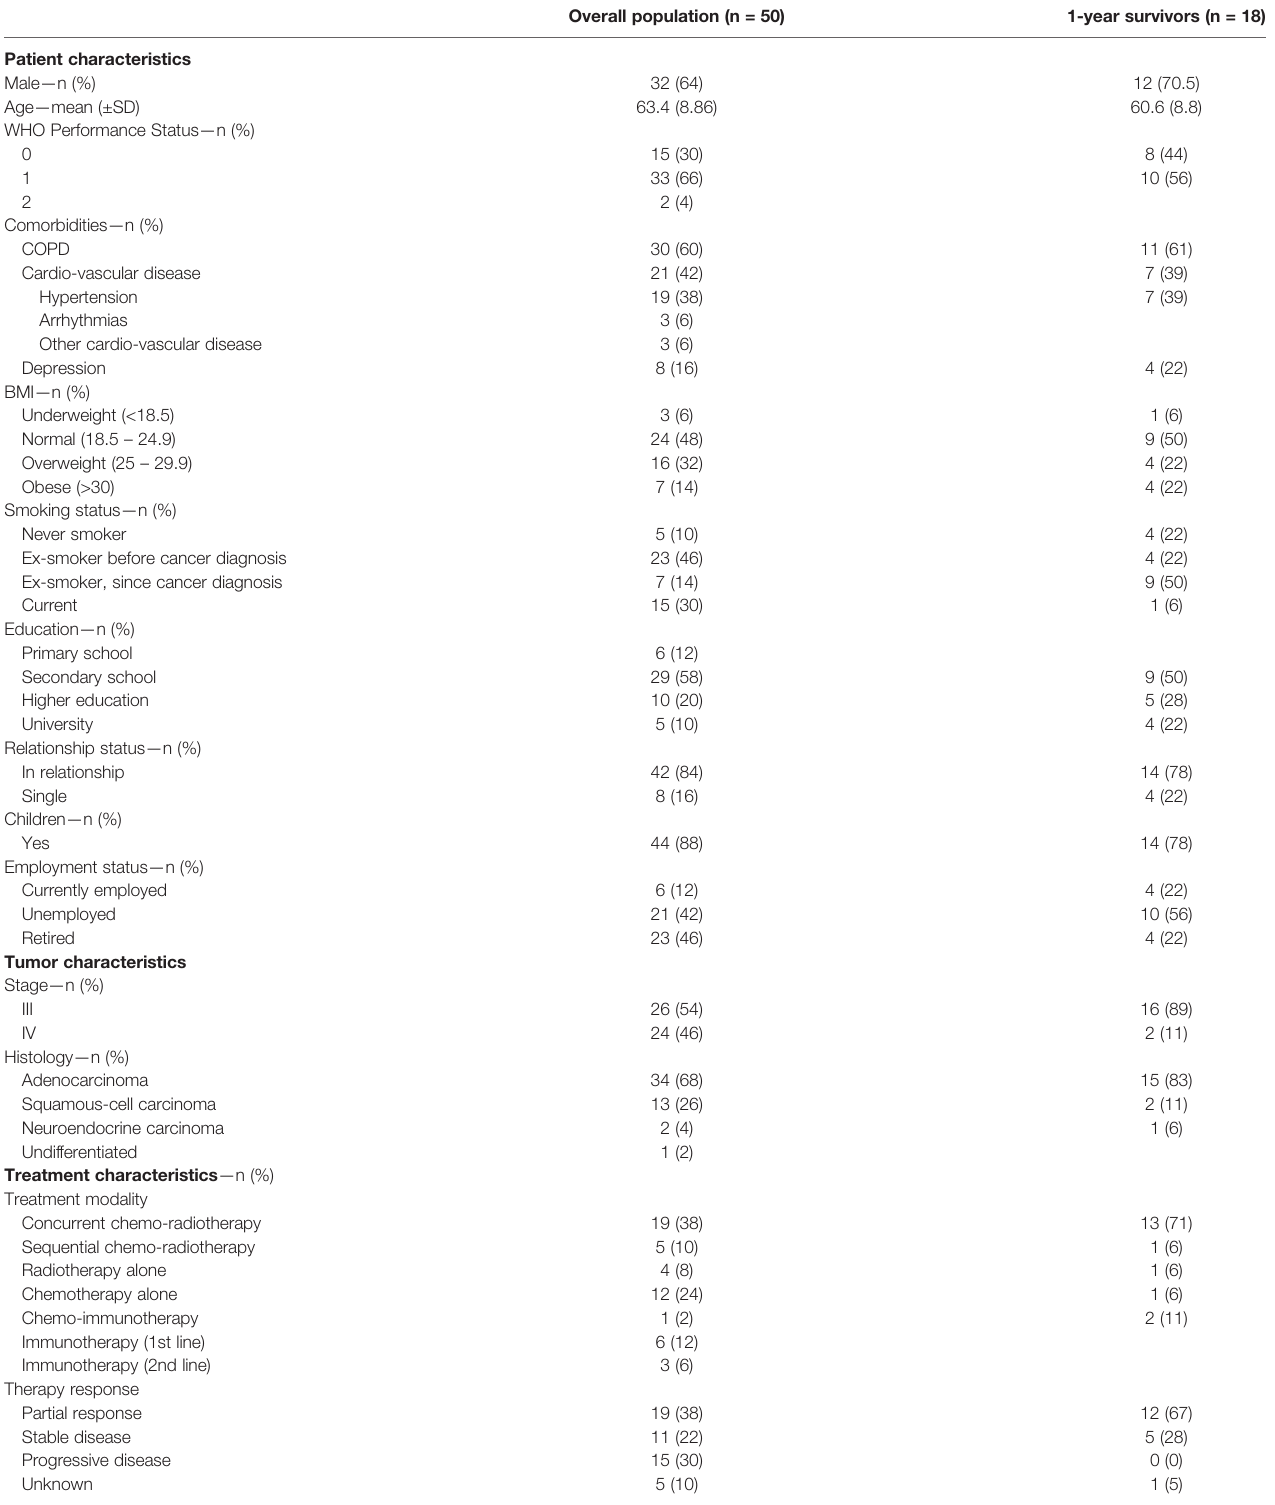
TABLE 1 | Patient, tumor, treatment and HRQoL characteristics at baseline and for 1-year